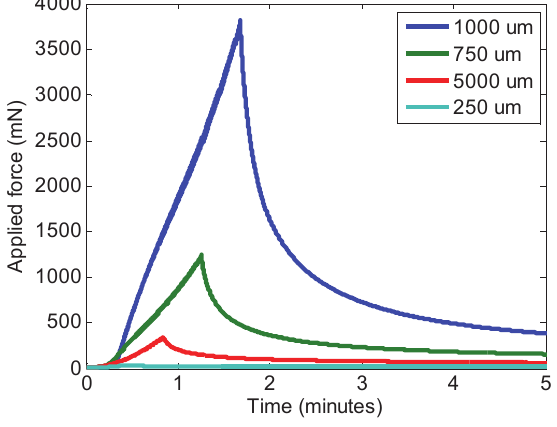
Fig. 11: Measured force during large strain indentation experiments on acellular alginate. Legend denotes final indentation